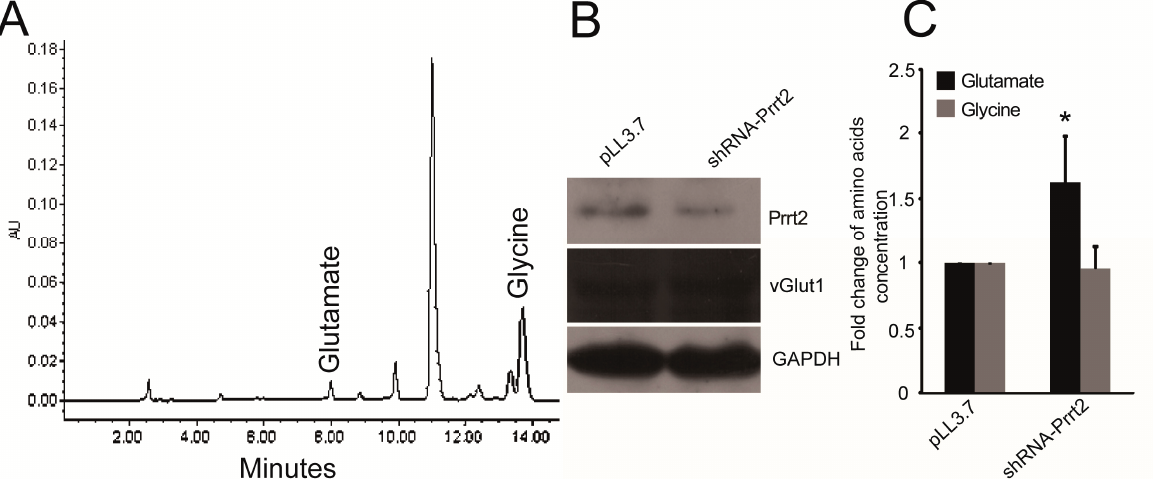
Figure 2. Knocking down Prrt2 increased glutamate level in the culture